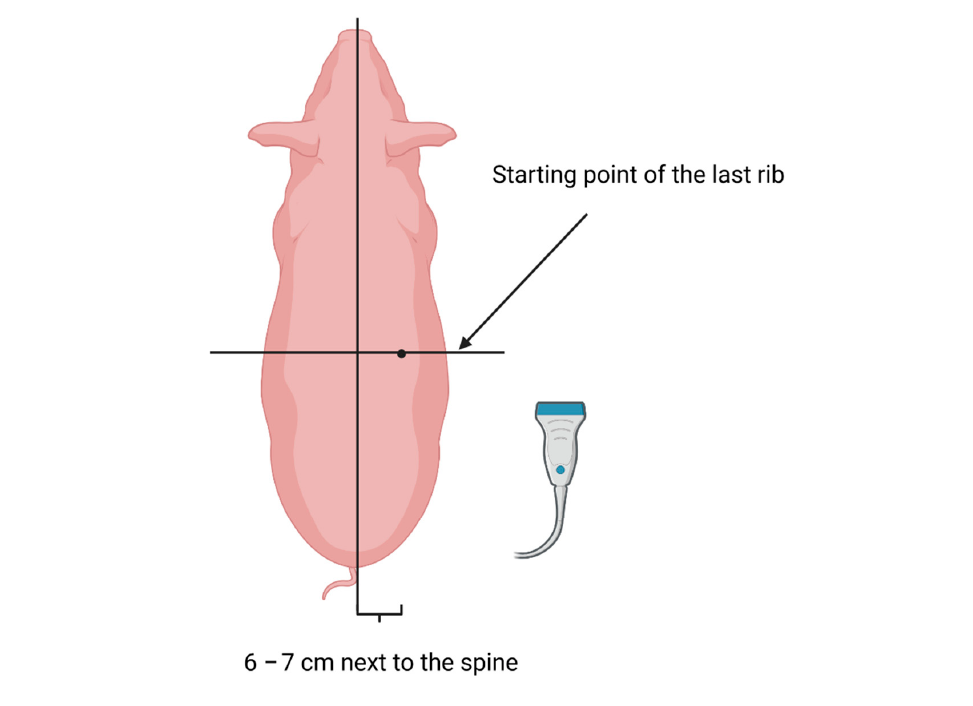
Figure 4. Measuring location for backfat measurement with Lean-meater ® (series 12, Renco Corp., Golden Valley, MN, USA) in accordance with the modified P2 method. (Figure was created with BioRender.com).